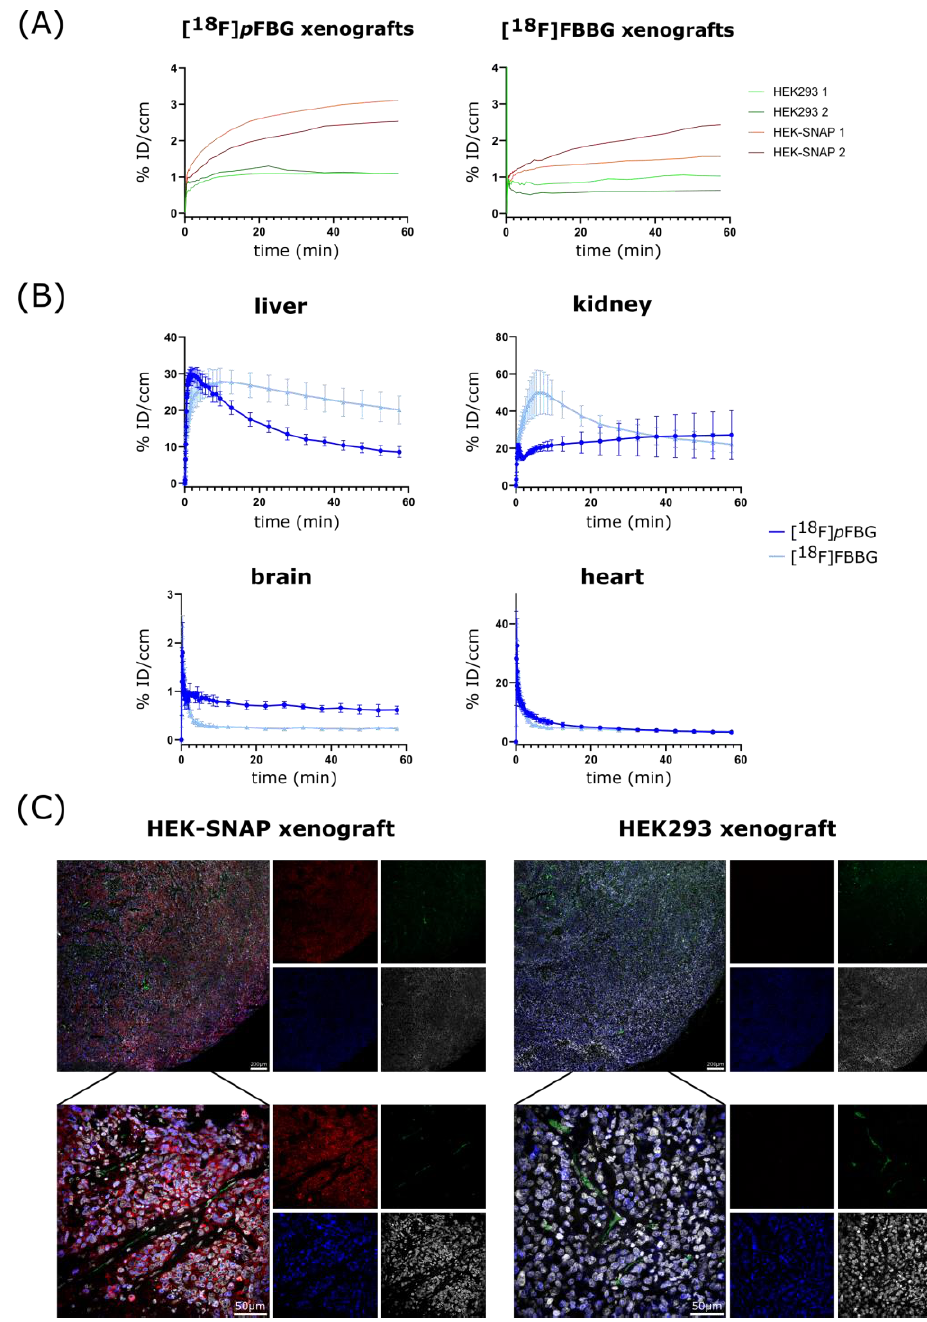
Figure 4. Pharmacokinetic evaluation of [ 18 F] p FBG and [ 18 F]FBBG, and ex vivo immunofluorescence. ( A ) TACs of the individual xenografts. HEK-SNAP xenografts are plotted in red and HEK293 control xenografts in green. ( B ) TACs of liver, kidney brain and heart for [ 18 F] p FBG (dark blue) and [ 18 F]FBBG (light blue) ( n = 4). ( C ) Representative immunofluorescence images of HEK293 xenograft tissue and HEK-SNAP xenograft tissue. CD31 is stained in green, Ki67 blue, nuclei are displayed in grey and the SNAP protein was visualized by an anti- myc -tag antibody shown in red.